Question: What caption would you write for this figure?
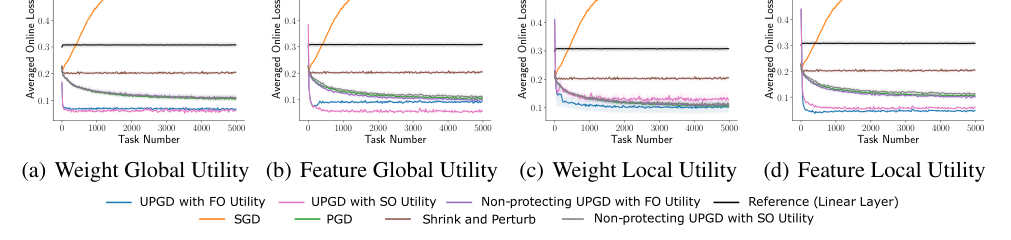
Answer: Performance of UPGD on the toy problem with changing output sign against SGD, PGD, and S&P. First-order and second-order approximated utilities are used.